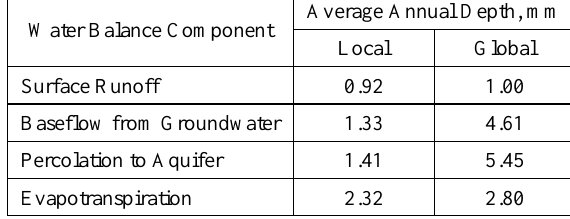
Table 2. Water balance average annual depths.